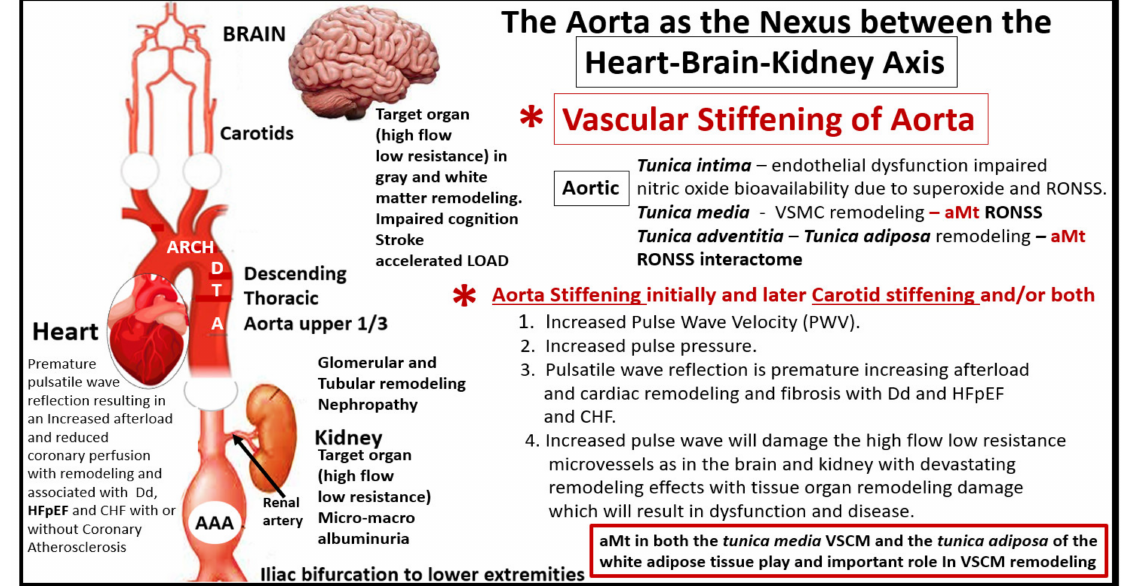
Figure 27. Descending thoracic aortic stiffening as the nexus between the heart-brain-kidney axis. This montage image illustrates the importance of aortic stiffening and the increased pulse wave velocity (PWV) with aberrant wave reflection to the heart and increased afterload resulting in myocardial remodeling and the increased pulsatile PWV to the target organs of high flow and low resistance microvessels especially in the capillaries of brain and kidney due to aortic stiffening with resultant damage and injury and the response to injury remodeling. Importantly, note that the aberrant mitochondria (aMt) in the tunica media vascular smooth muscle cells (VSMCs) and the aMt in the tunica adiposa of the adventitia in the descending thoracic aorta may also play an important role in thoracic aortic stiffening. A = aorta; AAA = abdominal aortic aneurysm; CHF = congestive heart failure; D = descending; Dd = diastolic dysfunction; HFpEF = heart failure with preserved ejection fraction; LOAD = late-onset Alzheimer’s disease; PWV = pulse wave velocity; ROS = reactive oxygen species; RONSS = reactive oxygen, nitrogen, sulfur